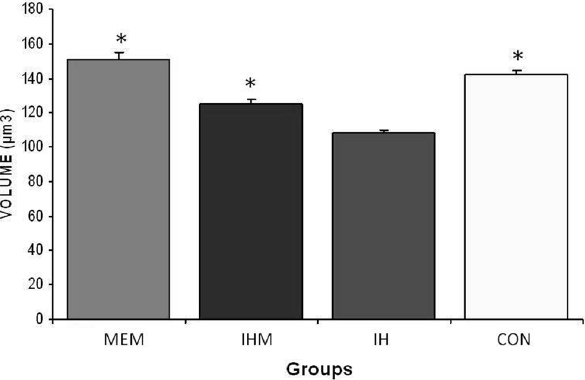
Figure 1 - The nuclear size of cardiomyocytes in the control (CON), memantine-treated (MEM), induced hypothermic/memantine-treated (IHM) and induced hypothermic (IH) groups. *p<0.05 for IH as compared to the other groups